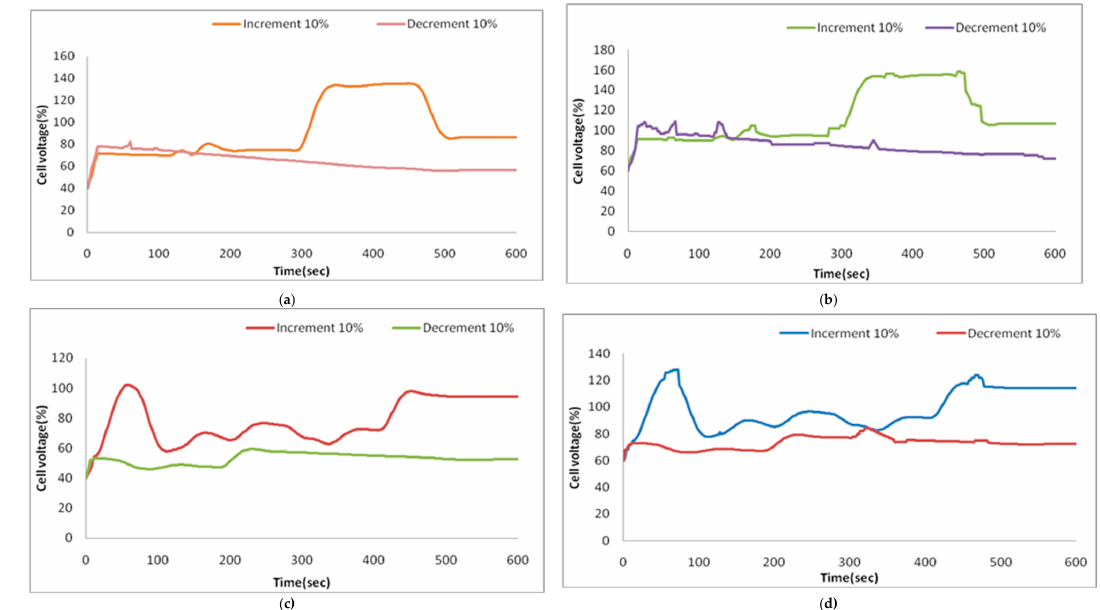
Figure 4. ( a ) Ala Eldin Abdallah Awouda, et al. Turning Rule (ARTR): real time set point tracking at the 40% operating point. ( b ) ARTR: real time set point at the 60% operating point. ( c ) Padma Sree, et al. Tuning rule (PSCTR): real time set point at the 40% operating point. ( d ) PSCTR: real time set point tracking at the 60% operating